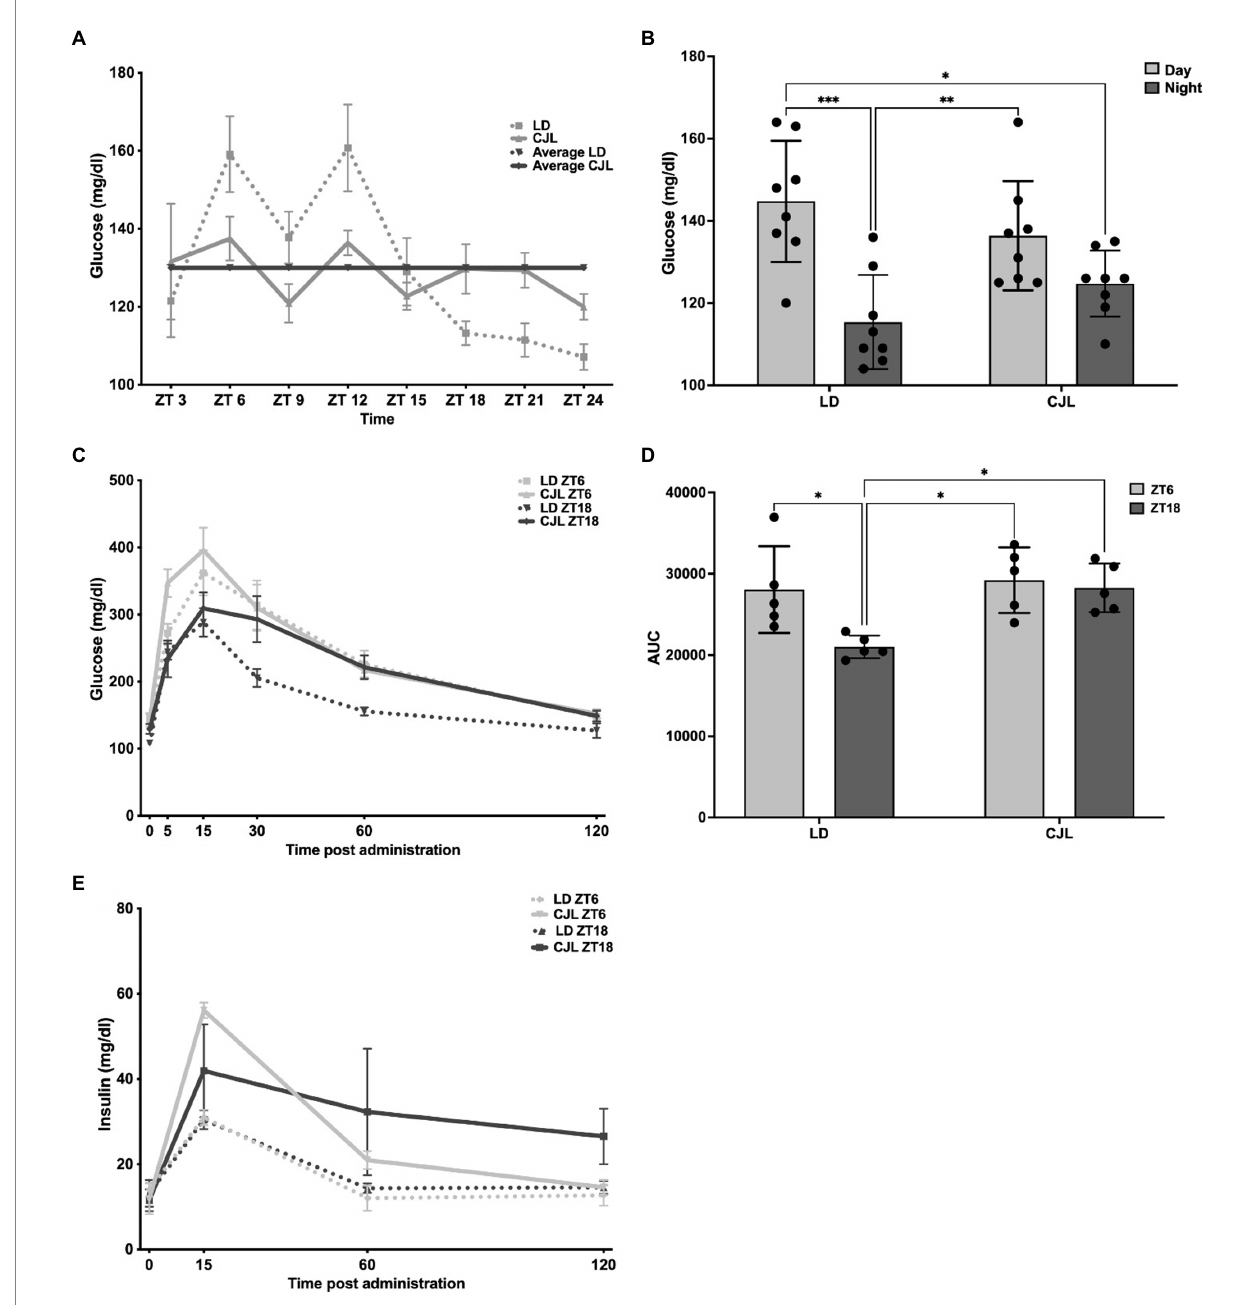
FIGURE 2 Daily glucose homeostasis is altered under CJL conditions. (A) Daily rhythm in blood glucose concentration (mg/dl) under ad libitum feeding along LD 12:12 in control mice under LD (dotted line) and under CJL (solid line). The daily mean for each group is also indicated. Two-way ANOVA, p = 0.0058, F = 3.05 for interaction; p < 0.0001, F = 6.145 for ZT; p = 0.682, F = 0.1685 for light schedule. Mean values for each ZT of control mice ( n = 5) were significantly adjusted to a cosine wave of 24 h (Ho: amplitude = 0, p < 0.05), having the following parameters: MESOR: 130 mg/dl, amplitude: 34.4 mg/dl, acrophase: ZT7. (B) Mean values obtained by averaging ZT3, ZT6, ZT9, ZT12 for light, and ZT15, ZT18, ZT21, ZT0 for dark conditions. During the light phase, the values increase and in the dark, the values decrease for LD and CJL conditions. Two-way ANOVA, p = 0.0481, F = 4.271 for interaction; p < 0.0001, F = 22.79 for day and night; followed by Tukey’s multiple comparisons test: *** p < 0.001, ** p < 0.01, * p < 0.05; n = 8. (C) Blood glucose concentration kinetics after delivering 2 g/kg ( t = 0) intraperitoneal glucose (IPGTT) in mice under LD (dotted line) at or under CJL (solid line), both at ZT6 (gray) or ZT18 (black). Glycemia values were measured at t = 0, t = 5, t = 15, t = 30, t = 60, and t = 120 (min) after glucose administration. Significant differences were found for glycemia kinetics between LD and CJL; however, no significant differences were observed for the two ZTs. Values are expressed as mean ± SEM at each time. Three-ways ANOVA, p < 0.0001, F = 20.63 for time; p = 0.006, F = 26.75 for light schedule; p = 0.2861, F = 1.51 for ZTs; p = 0.28, F = 2.75 for time × time schedule; p = 0.37, F = 1.14 for time × ZT; p = 0.56, F = 0.39 for time schedule × ZT; p = 0.55, F = 0.72 for time × time schedule × ZT. (D) Value of the area under the curve (AUC) to estimate the rate of appearance/disappearance of blood glucose, as an indicator of tolerance. A lower value was observed in LD at ZT18 compared to the CJL condition. Values represented as mean ± SEM. Two-way ANOVA, p = 0.0871, F = 3.322 for interaction; p = 0.0227, F = 6.357 for light schedule; p = 0.0293, F = 5.726 for ZT; followed by Tukey’s multiple comparisons test: * p < 0.05; n = 5. (E) Blood insulin values after delivering 2 g/kg ( t = 0) intraperitoneal glucose (IPGTT) in mice under LD (dotted line) at or under CJL (solid line), both at ZT6 (gray) or ZT18 (black). Insulin values were measured at t = 0, t = 5, t = 15, t = 30, t = 60, and t = 120 (min) after glucose administration. Values are expressed as mean ± SEM at each